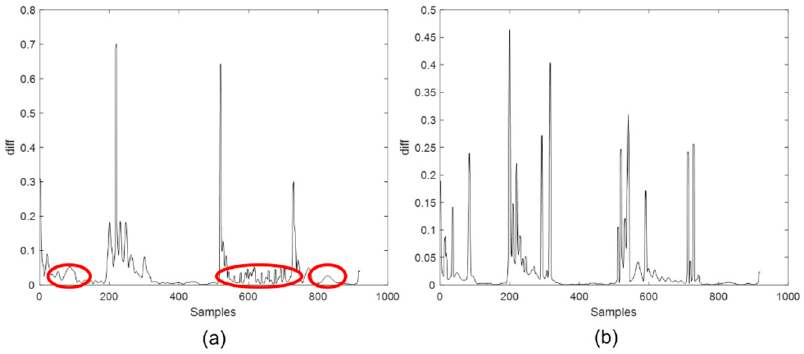
Figure 7. The trend of dif f β calculated by ( a ) ridge regression method and ( b ) PLS method in the time direction.